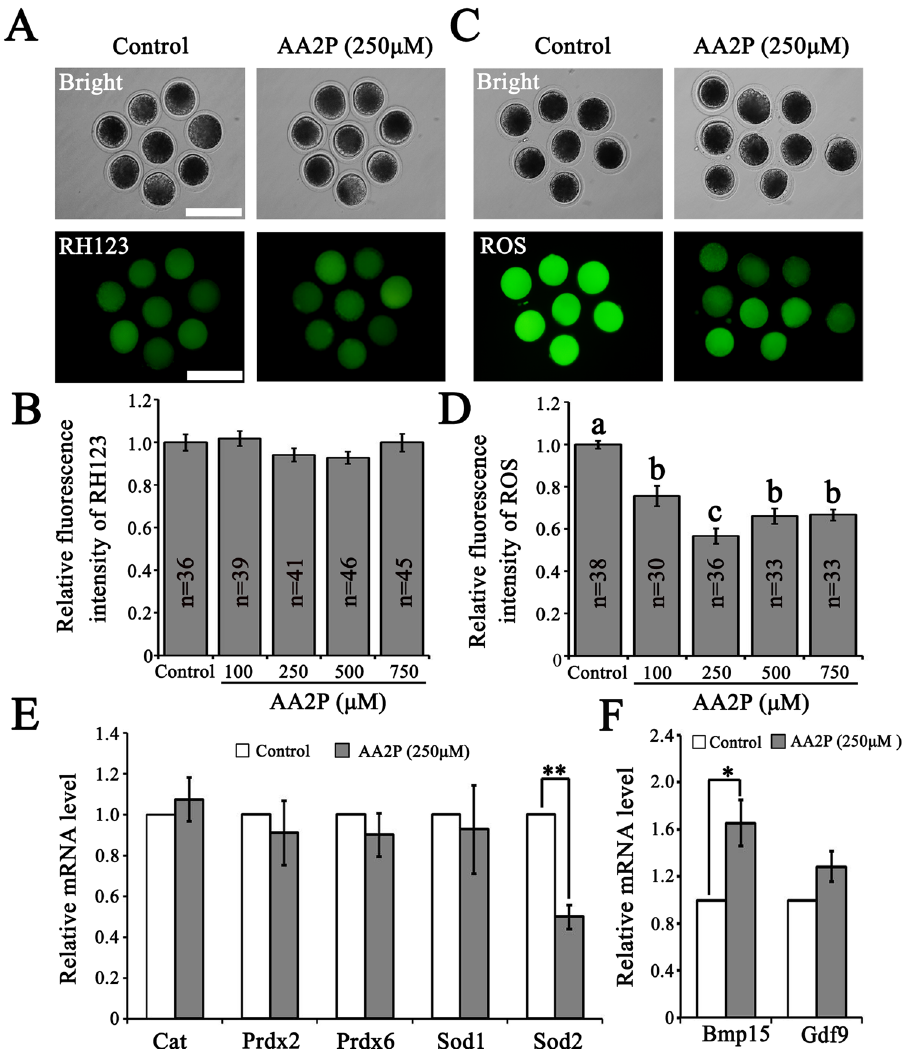
Figure 2. AA2P improves the cytoplasmic quality of pig oocytes. ( A , C ) The representative images of RH123 and ROS staining in oocytes from control and 250 µ M AA2P treated groups. Scale bar: 200 µ m. ( B , D ) The fluorescence values of RH123 and ROS levels in oocytes from control and AA2P treated groups. Different lowercase letters a, b and c indicate significant differences at P < 0.05 level. ( E , F ) RT-qPCR analysis on oxidative stress-related genes ( Cat , Prdx2 , Prdx6 , Sod1 and Sod2 ) and oocyte secreted factors ( Bmp15 and Gdf9 ). * indicates significant difference at P < 0.05 level, ** P < 0.01